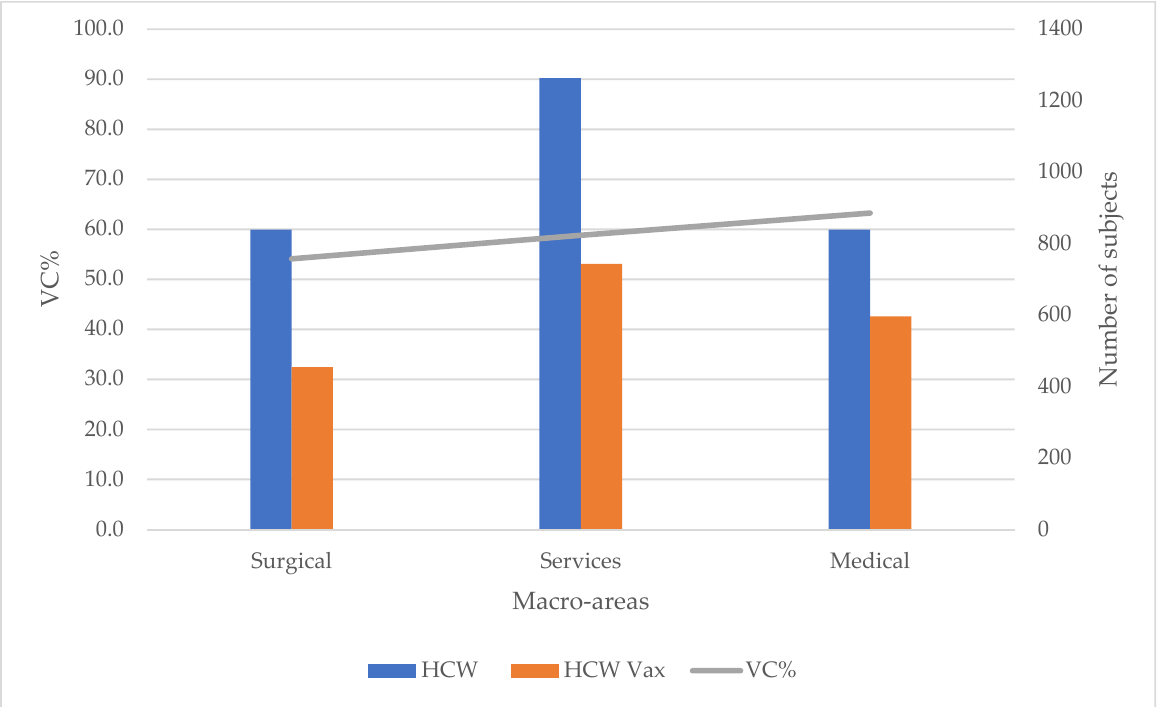
Figure 2. Vaccination coverage (VC%) in the 2020–2021 season of AOU-SS health personnel (HCWs) by macro-area. Vax = vaccinated. Table 9. Univariate and multivariate analysis. OR = Odds Ratio; CI = Confidence Interval. Table 8. Distribution by gender (F = females; M = males; Vax = vaccinated) of recorded vaccination coverage (VC%) among the different professional categories working at AOU-SS.